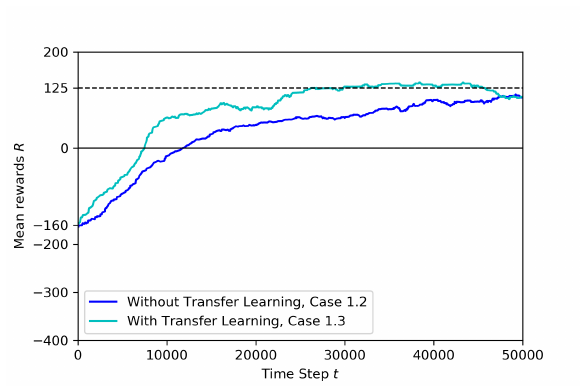
Figure 14. Training mean rewards for Case 1.1 and Case